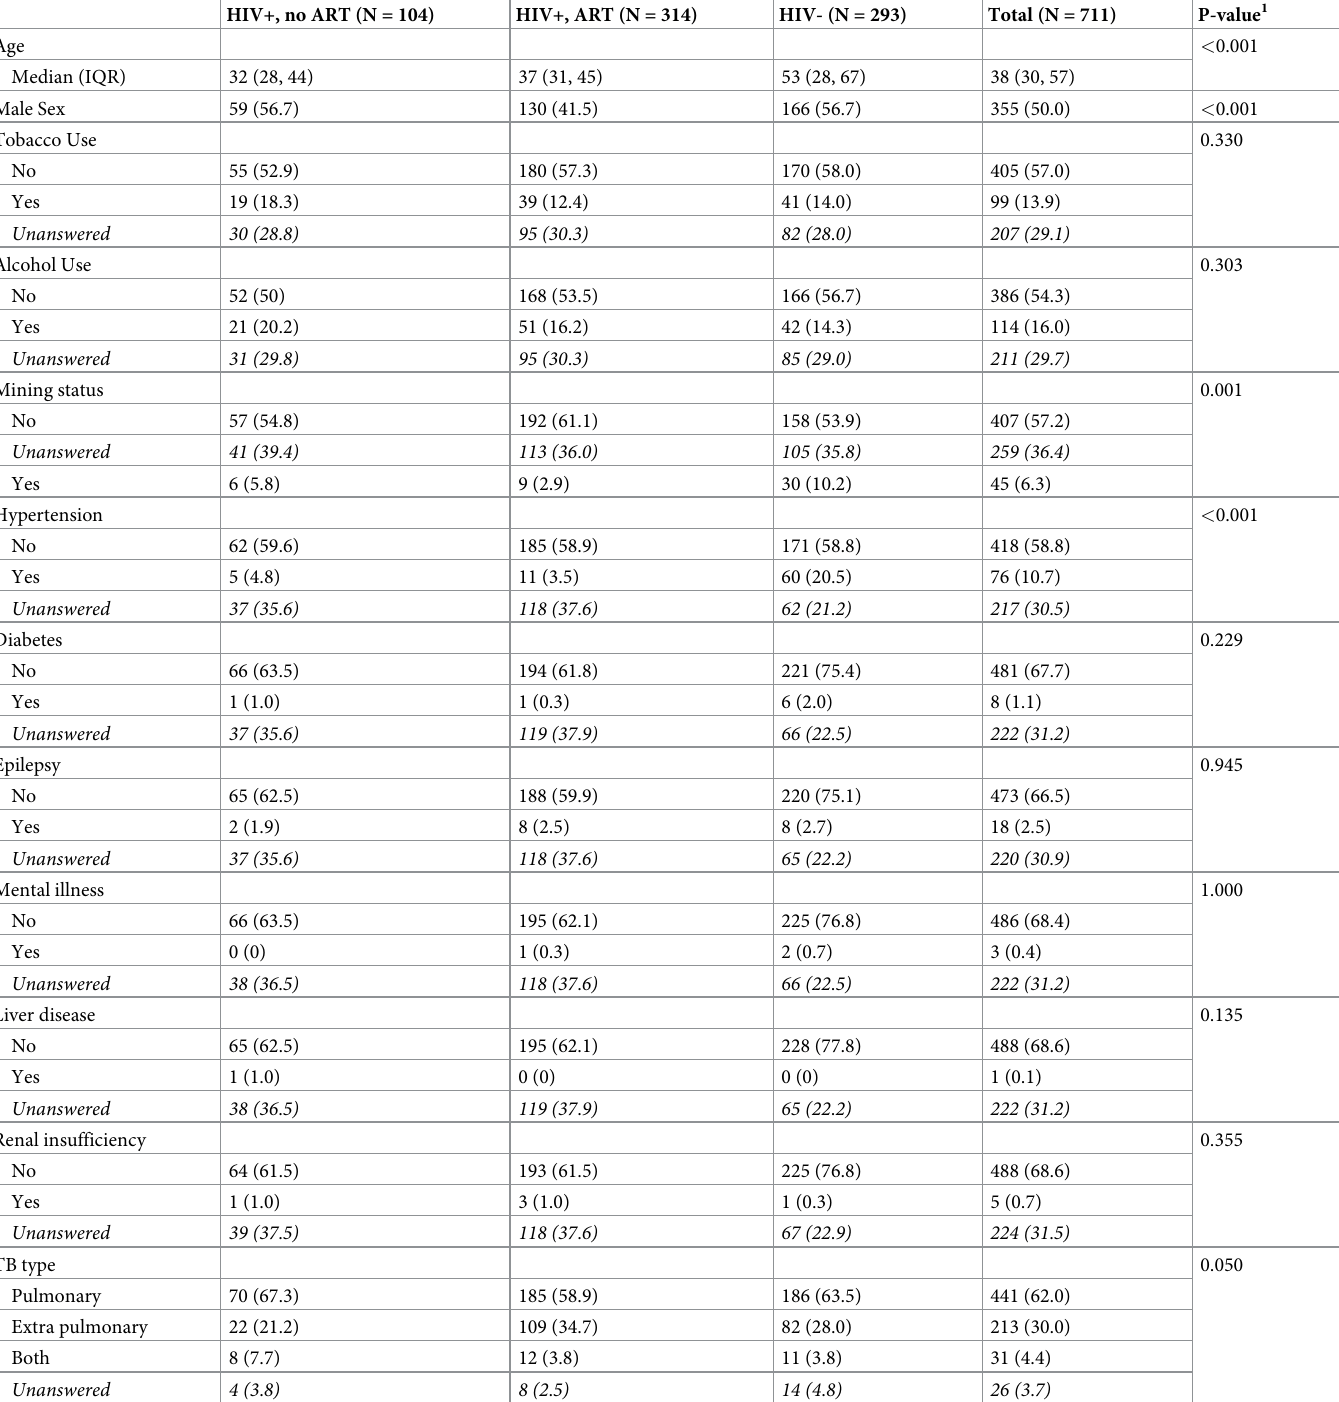
Table 1. Demographics of patients diagnosed with TB at a district hospital based on HIV and ART status (N =